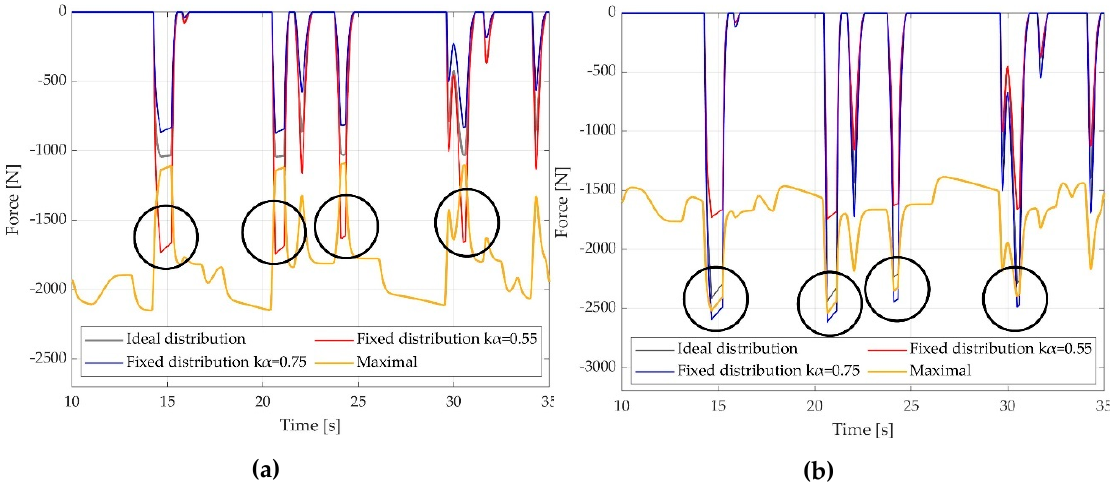
Figure 15. Comparison of braking forces and maximal forces (a) rear wheels; (b) front wheels.